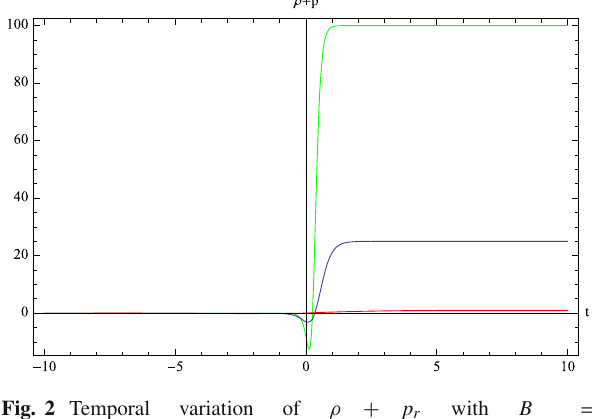
Fig. 2 Temporal variation of ρ + p r with B = 1 ( red ), 5 ( blue ), 10 ( green ) for D = 4